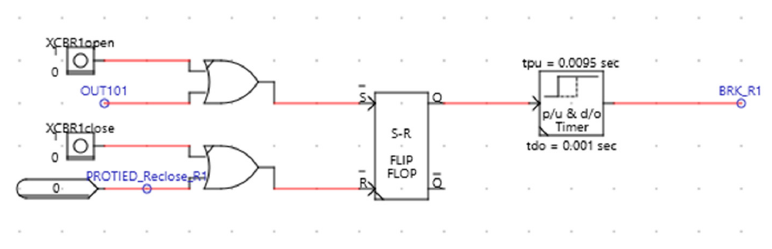
Figure 20. Circuit breaker logic for relay